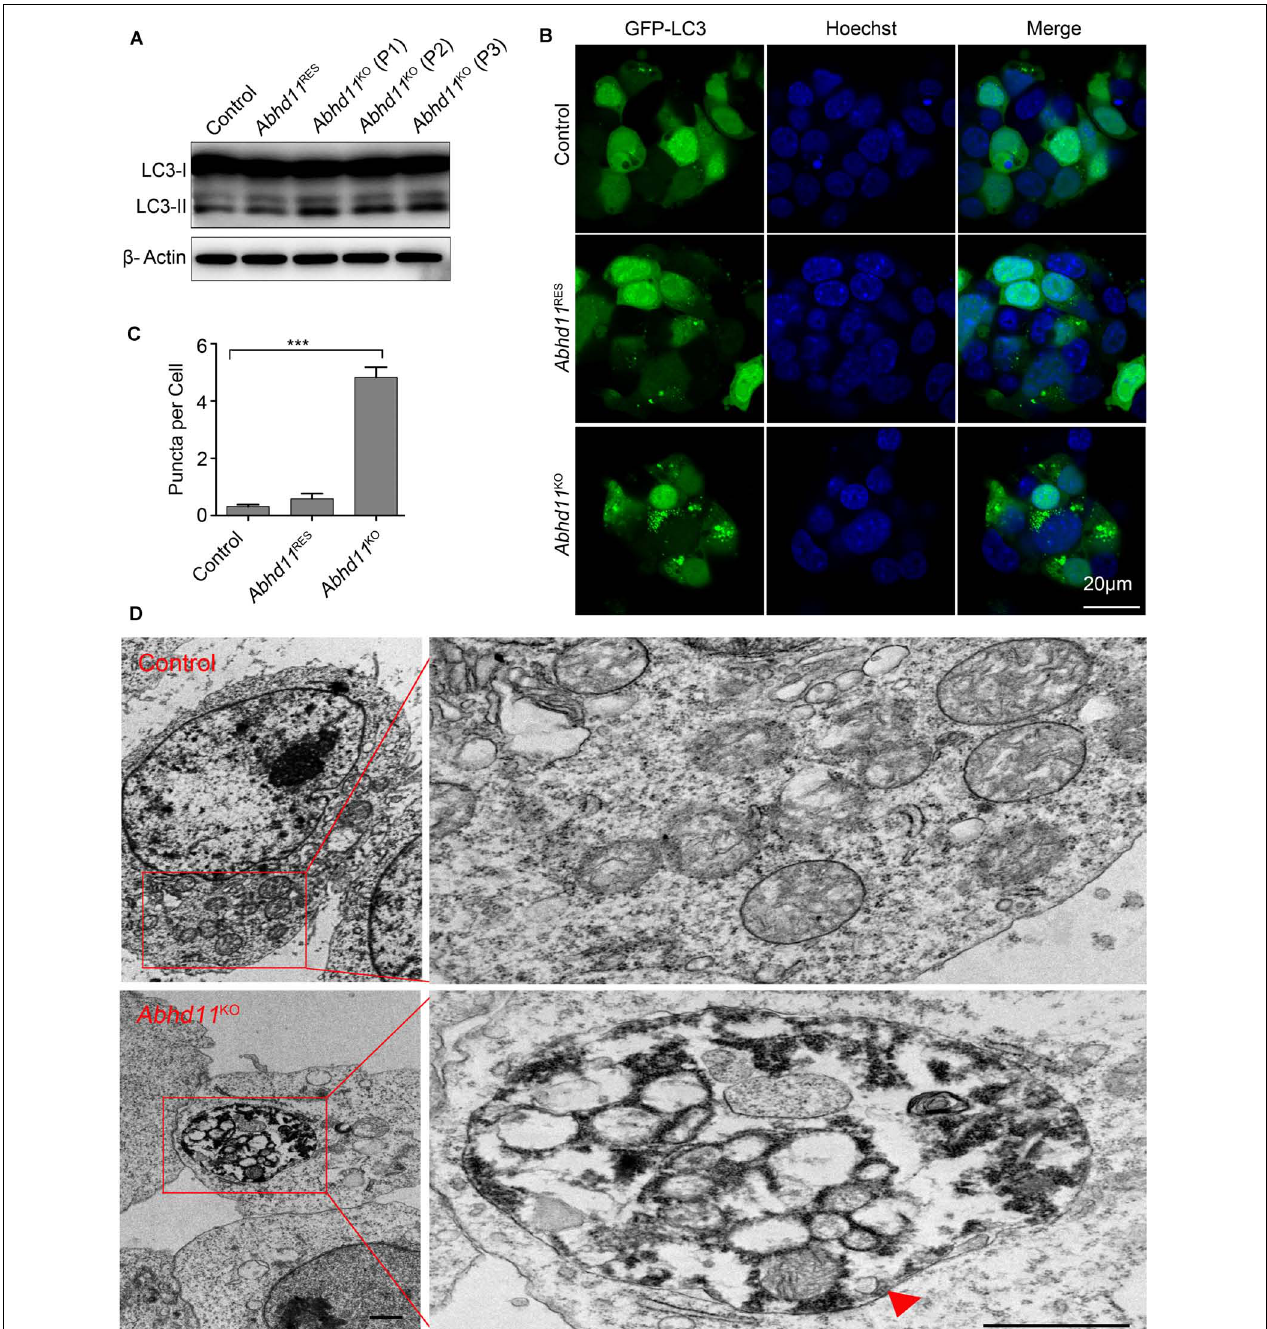
FIGURE 3 | Abhd11 KO induces autophagy. (A) Western blot analysis of LC3-I and LC3-II expression level in the indicated cells during passage (P) with anti- LC3 antibody. (B) Confocal fluorescence microscopy images showing the subcellular localization of GFP-LC3 in the indicated cells. (C) Quantification of GFP-LC3 puncta in the indicated cells. Data were represented as mean ± s.d. from three independent experiments and at least 50 cells in each experiment were counted. *** p < 0.001. (D) Representative TEM images of control ESCs and Abhd11 KO ESCs. A big autophagic vacuole appeared as double-membrane structure was highlighted with a red triangle. Scale bar, 1 µ